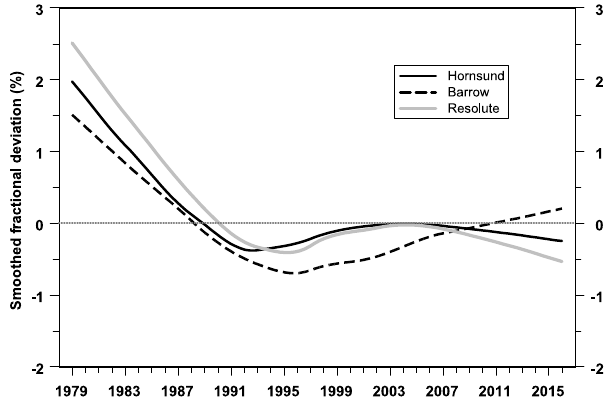
Figure 8. Smoothed time series (by LOWES smoother, Cleve- land, 1979) of annual fractional deviations of mean total ozone in the May–August periods for the period 1979–2016 at Hornsund (Svalbard, Norway), Barrow (Alaska, United States), and Resolute (Cornwallis Island,